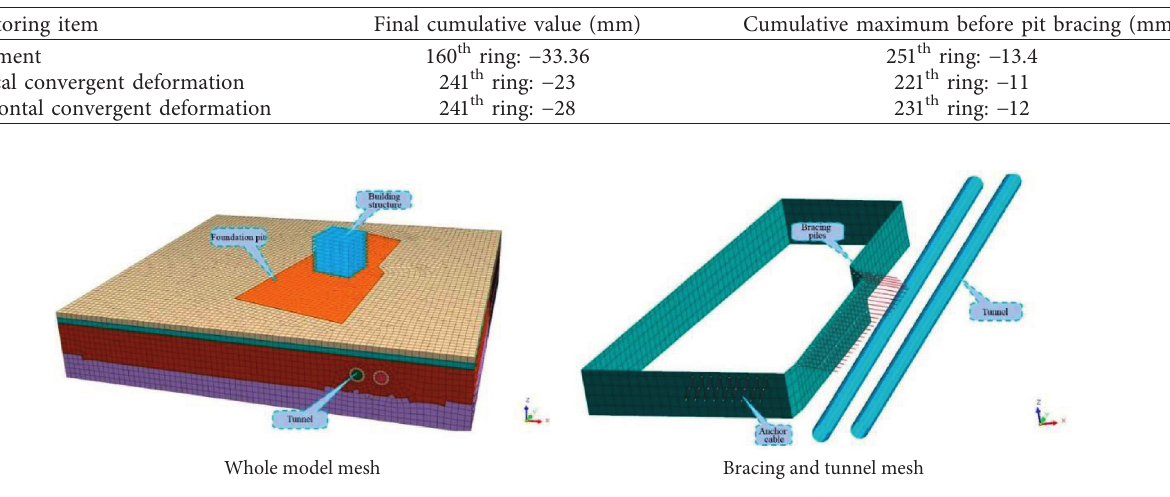
Figure 3: Tunnel displacement under the effect of pit excavation. Table 2: Tunnel interval monitoring data.